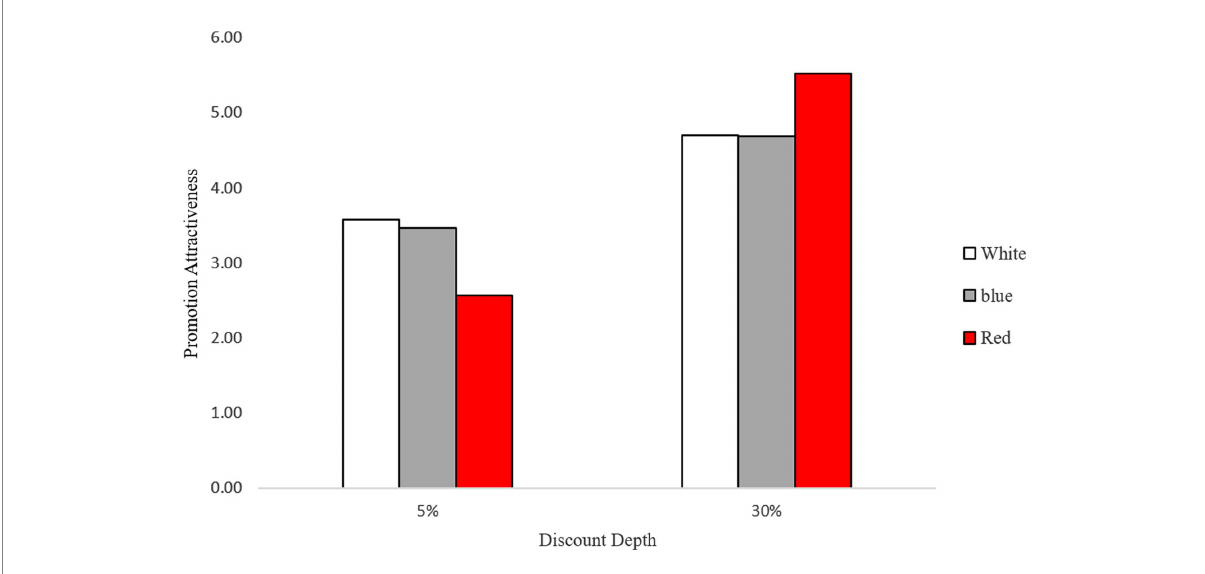
FIGURE 1 Promotion attractiveness as a function of background color and discount